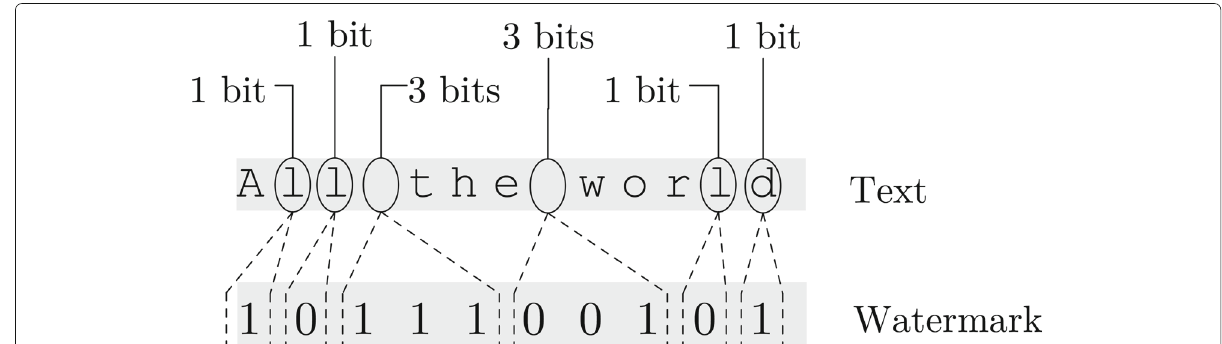
Fig. 2 Embedding watermark’s bits by replacing confusable symbols. Only the symbols with a related duplicate in Tables 1 and 2 are used to embed the watermark bits: one bit can be embedded on latin letters, and three bits can be embedded on space characters